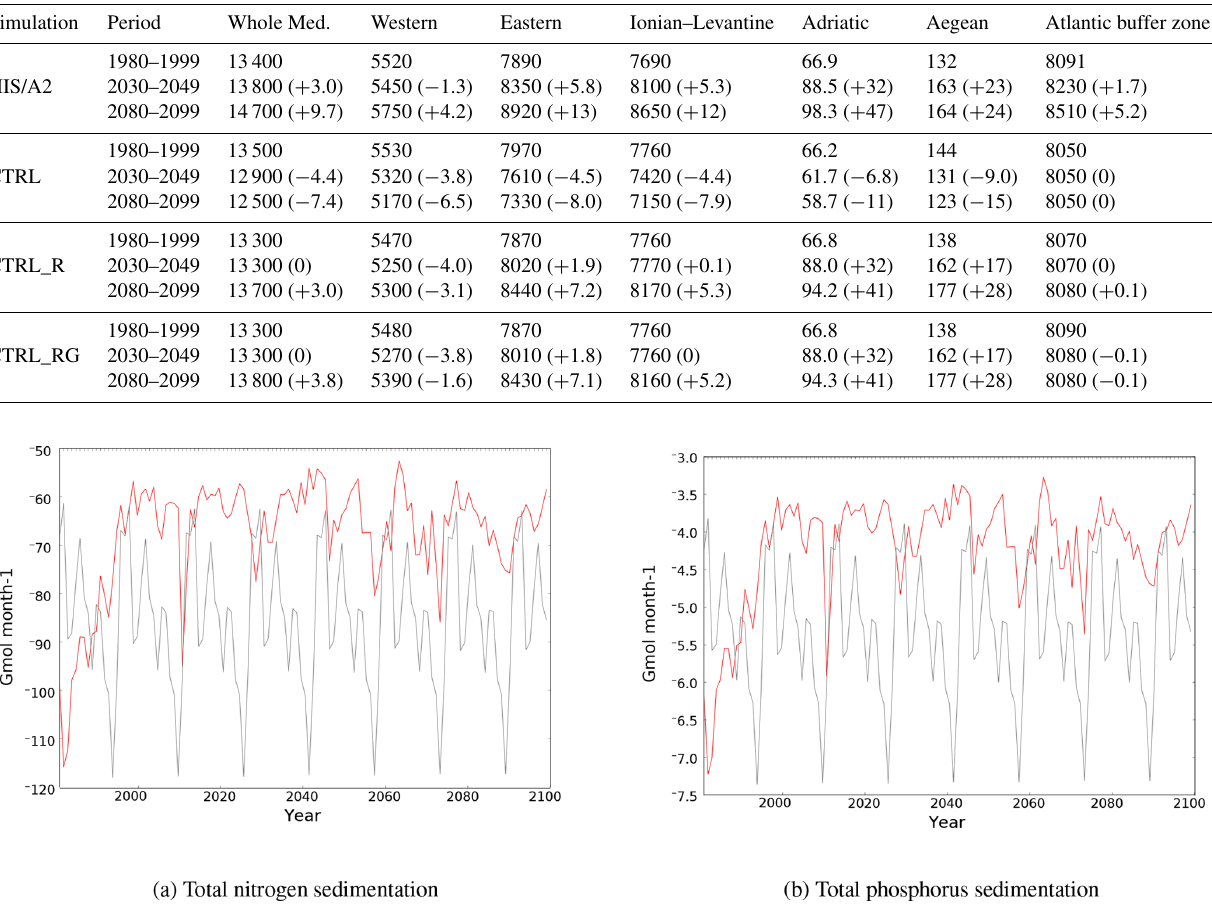
Figure 6. Evolution of total sedimentation fluxes of N and P (10 9 molmonth − 1 ) in the Mediterranean Sea in the CTRL (grey) and HIS/A2 (red) simulations. Negative fluxes indicate that the nutrients are exiting the Mediterranean